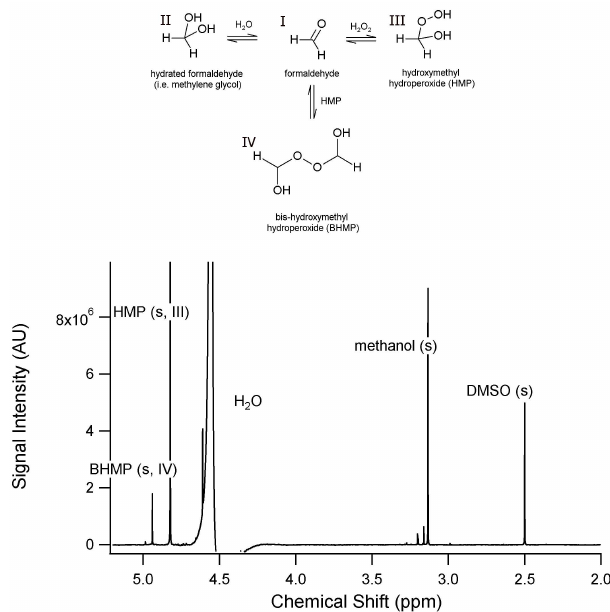
Fig. 6. 1 H NMR spectra of a formaldehyde-H 2 O 2 mixture. The splitting pattern and assignment of the peaks are shown in the